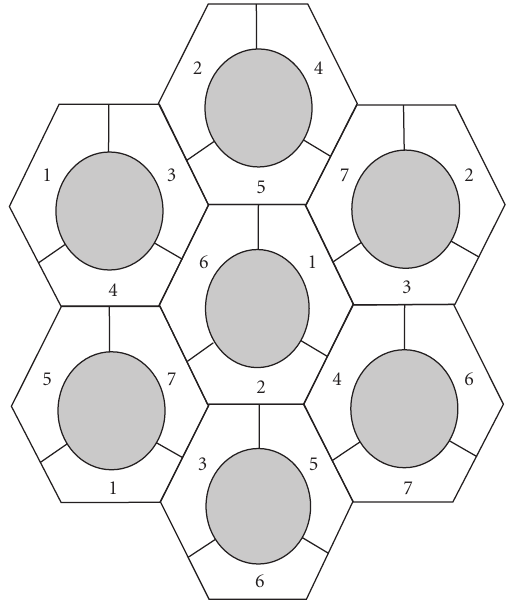
Figure 5: Illustration of SFR 3/7